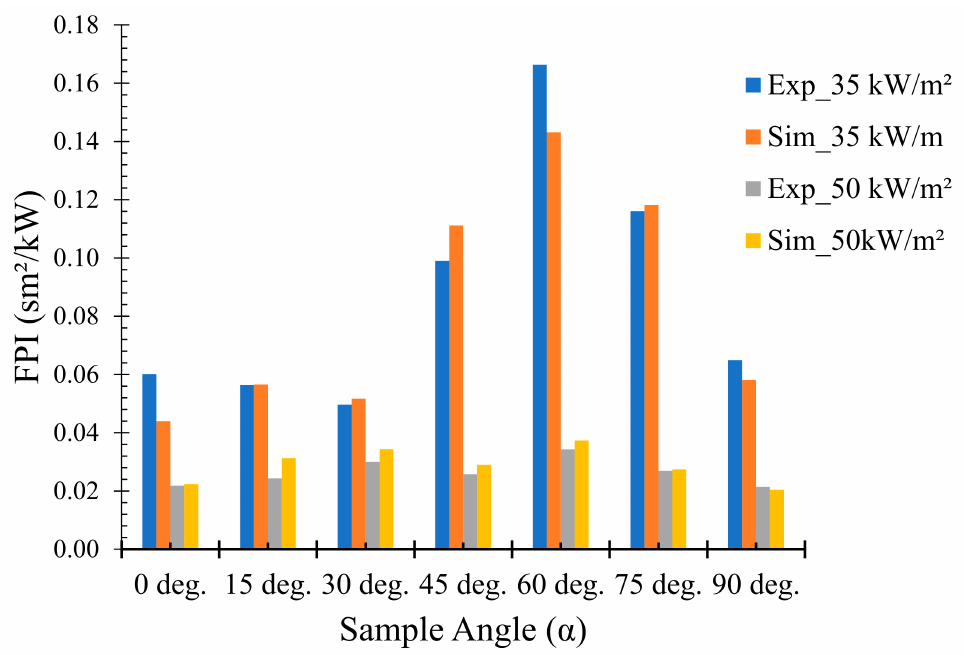
Figure 10. Comparison of experimental and numerical fire performance indices (FPI) of flax (25 wt.%)– PP composites at different sample orientation angles (0 ◦ = horizontal, 90 ◦ =